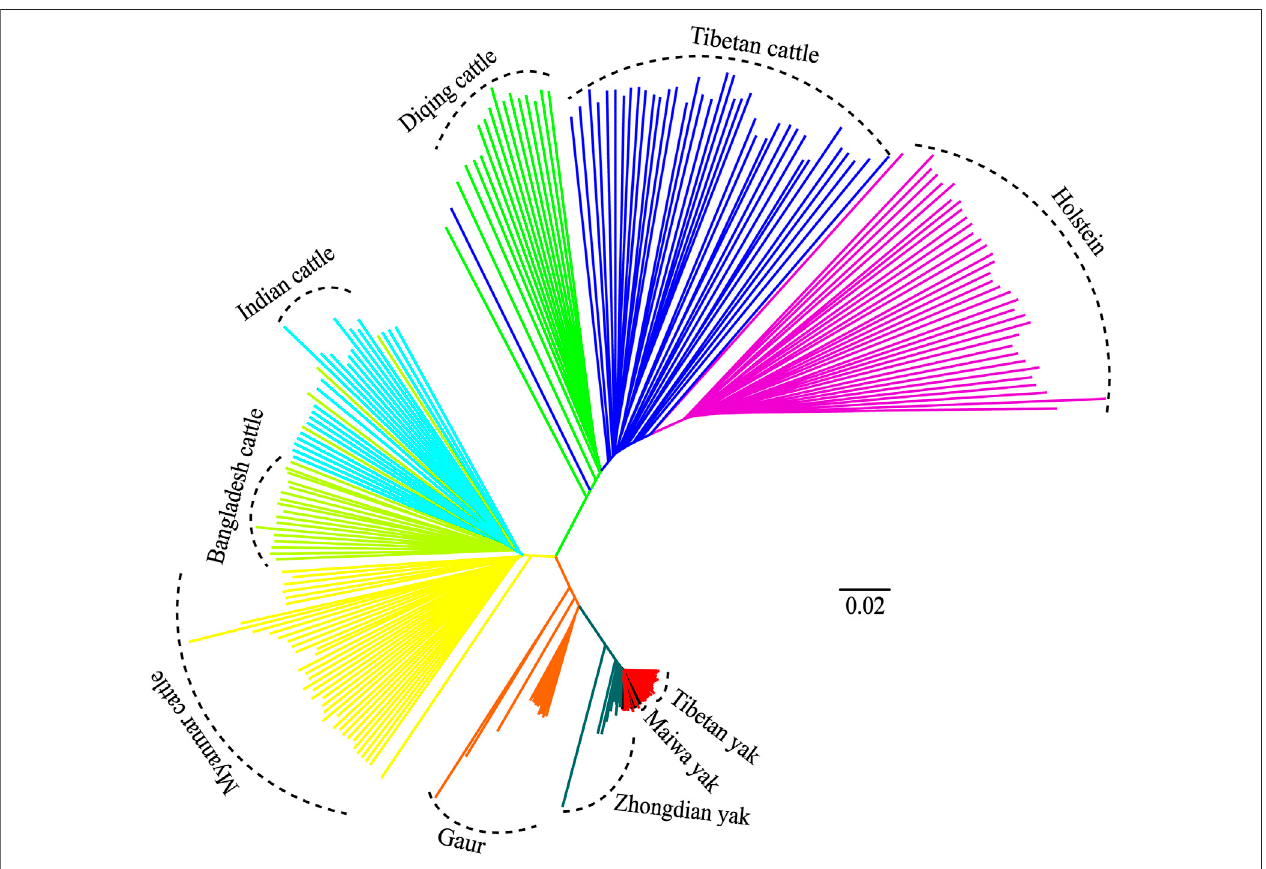
FIGURE 2 | Neighbor-joining (NJ) tree of 10 populations.